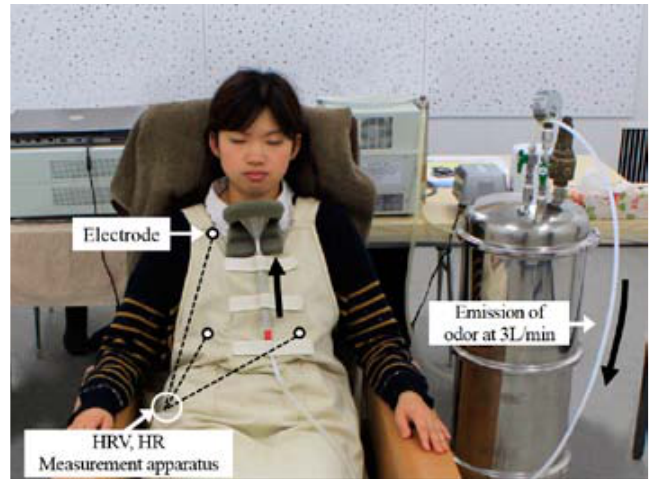
Fig. 1 - Olfactory stimulation